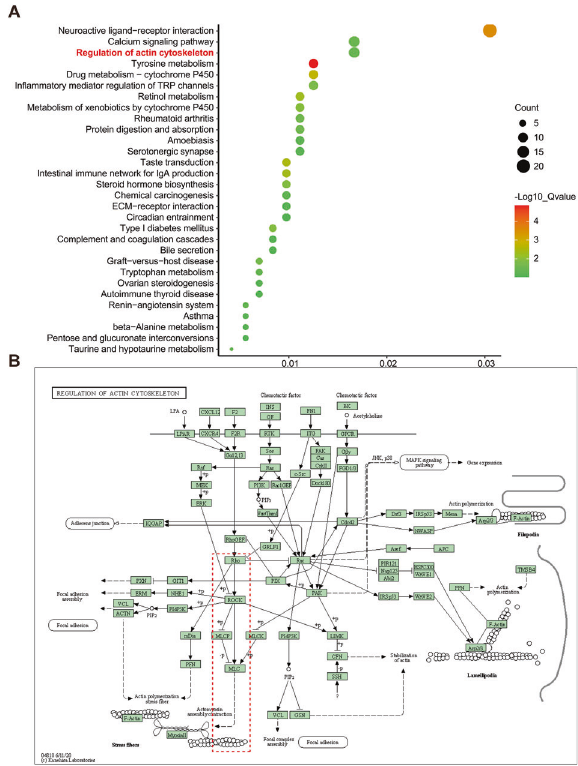
Fig. 3 The RhoA/ROCK pathway in regulation of actin cytoskele- ton. A , B Based on KEGG pathway enrichment analysis, the differentially expressed genes were enriched in the regulation of actin cytoskeleton pathway. In this pathway diagram, Rho, ROCK, and MLC were the key genes in the RhoA/ROCK